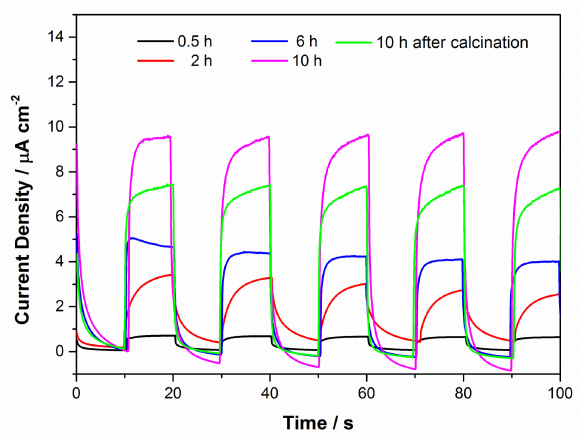
Figure 10. Transient photocurrent response of the samples with different reaction